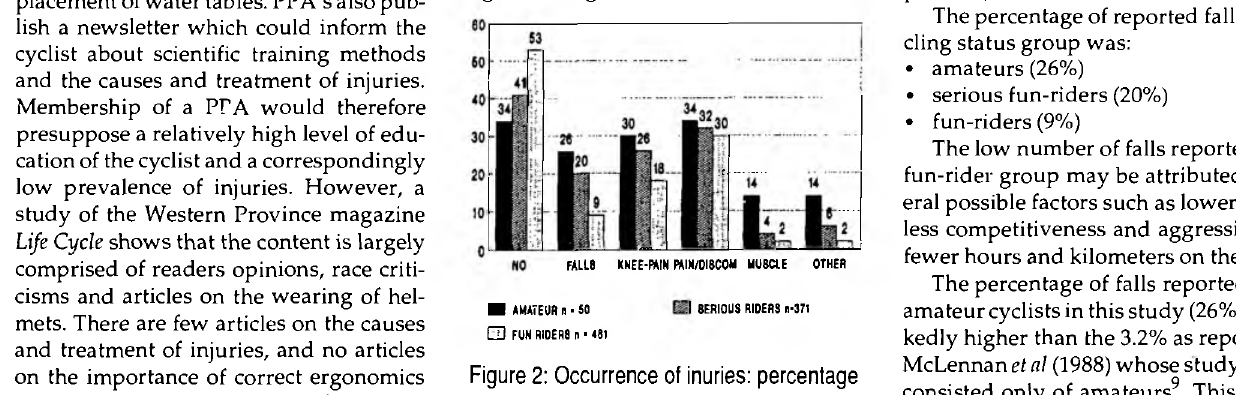
Figure 2: Occurrence of inuries: percentage per group The proportions of cyclists who